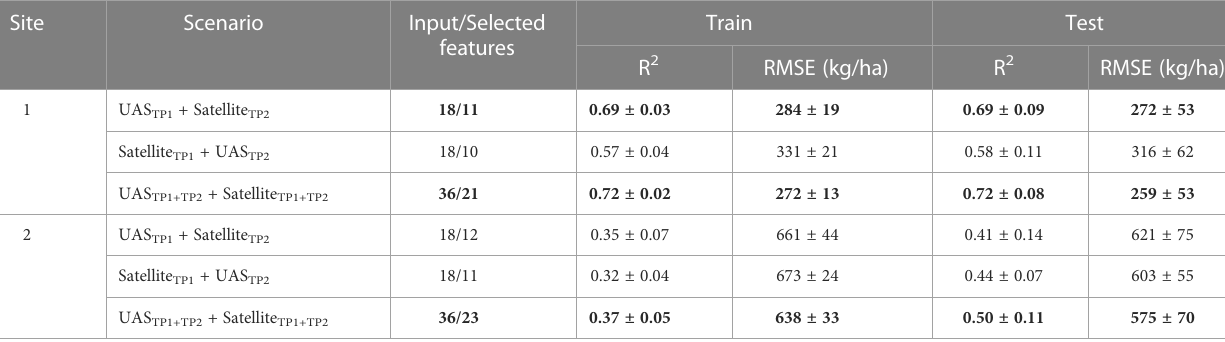
TABLE 2 Performance evaluation of models using multi-scale/sensor input